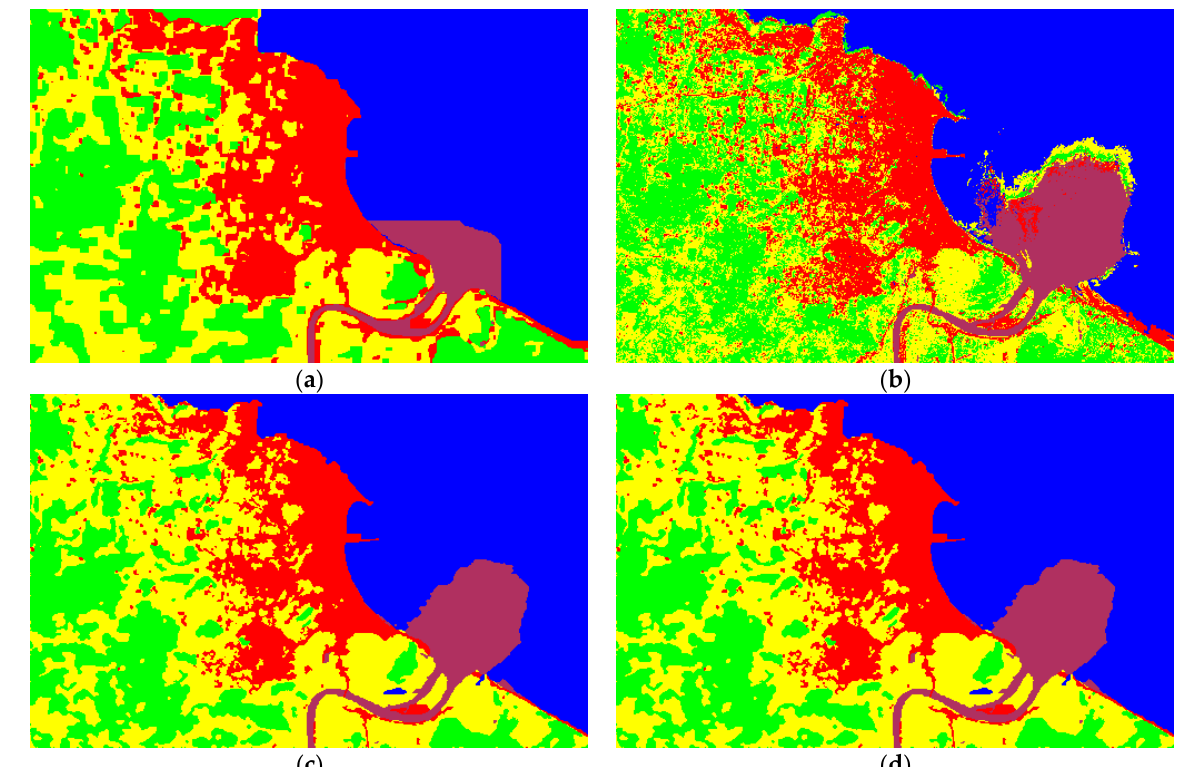
Figure 18. Different initializations in the case of Jérémie 2016: ( a ) initial classification map obtained via the method in [78]; ( b ) initial classification map obtained via RF; ( c ) final classification map obtained with the initialization in ( a ); ( d ) final classification map obtained with the initialization in ( b ). The legend is given in Table 1.